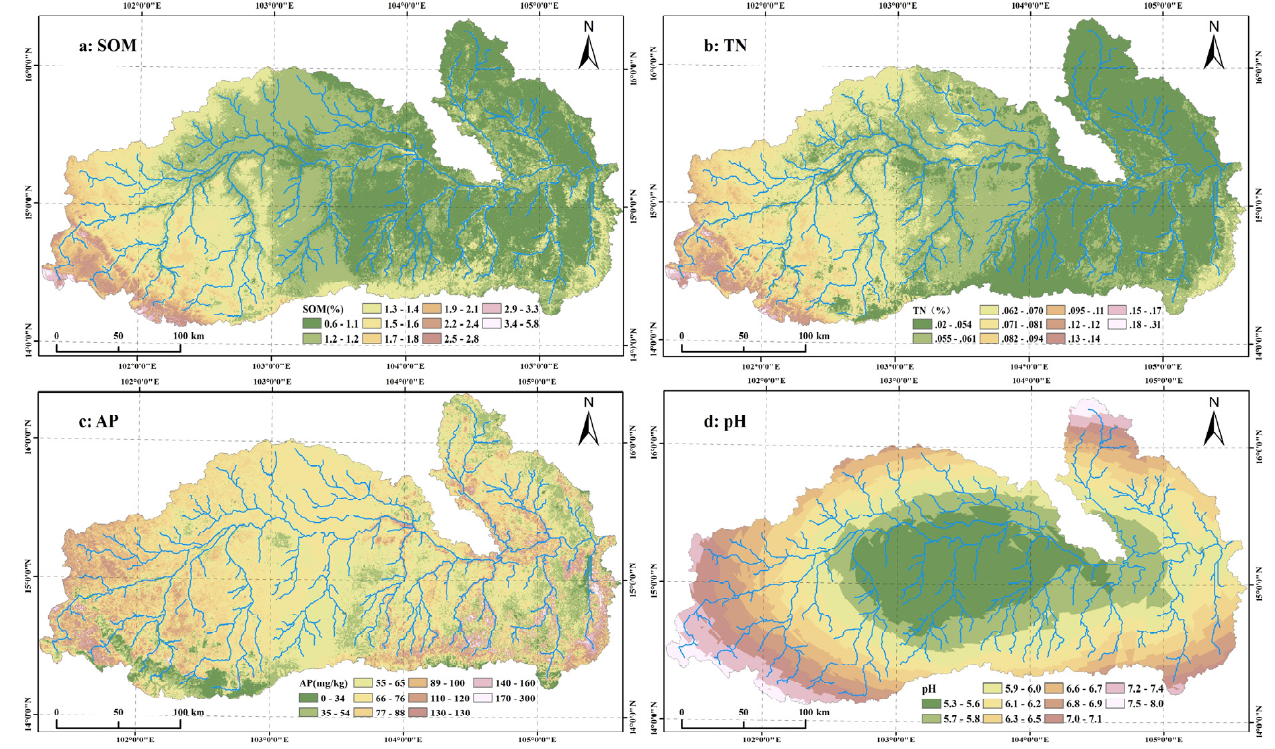
Figure 3. The spatial distributions of the four assessment indicators.